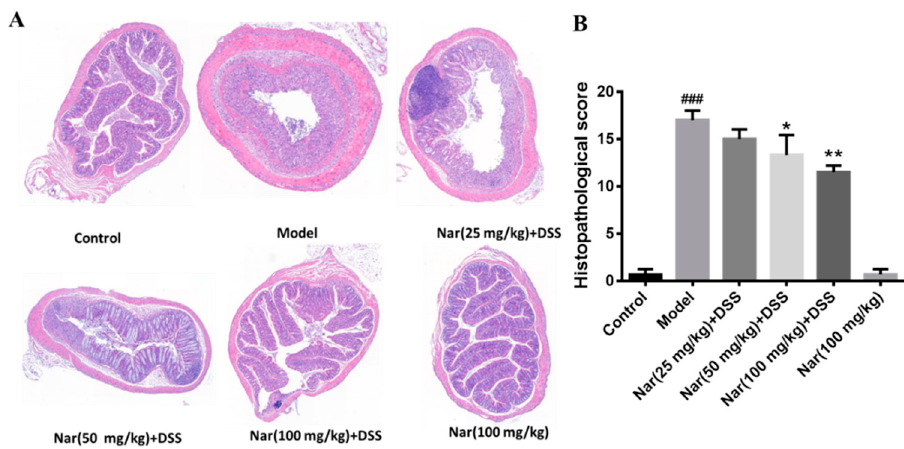
Figure 2. Histopathological changes of colons in ulcerative colitis mice were improved by naringin. ( A ) The colons of each group were processed for histological evaluation (H&E staining, 50 × ). ( B ) Histopathological scores of each group were evaluated. Data are presented as means ± SD ( n = 6). ### p < 0.001, compared with the control group; * p < 0.05 and ** p < 0.01, compared with the DSS model group.